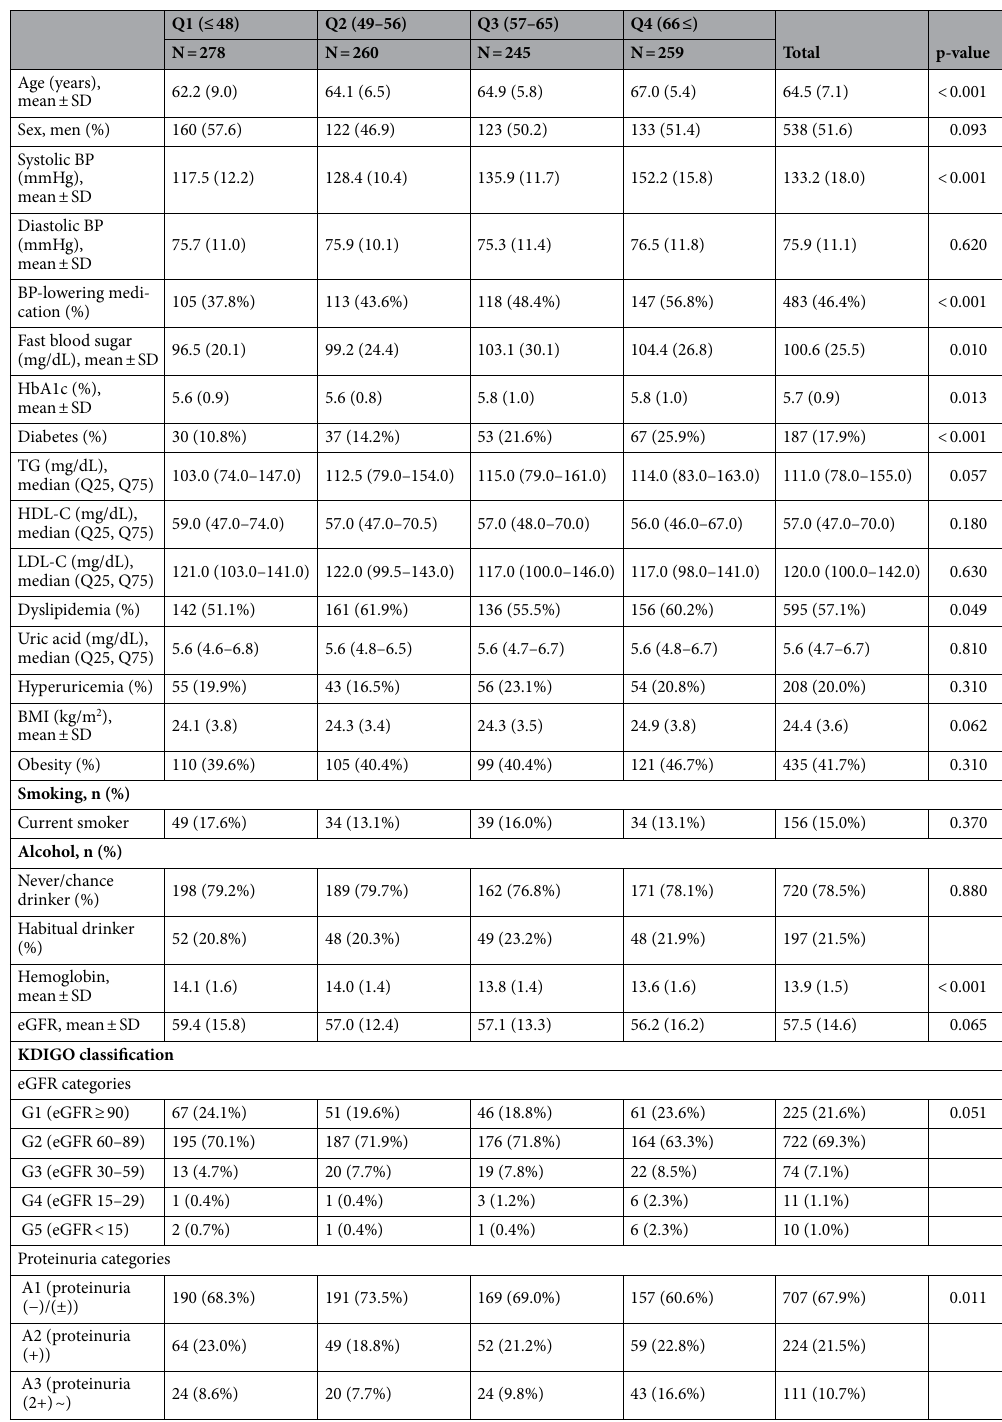
Table 1. Baseline characteristics of study participants by pulse pressure quartile. eGFR estimated glomerular filtration rate, KDIGO Kidney Disease: Improving Global Outcome, BMI body mass index, TG